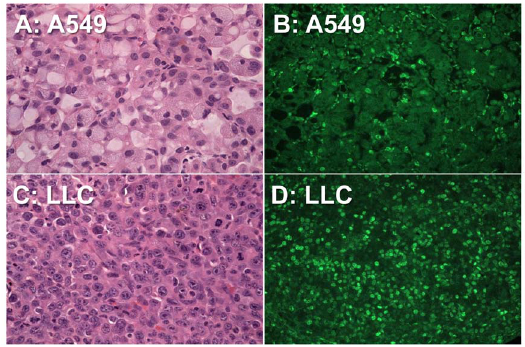
Figure 4. Micrographs of the A549 tumor and LCC tumor. Hematoxylin-eosin staining (original magnification 6 400) demonstrates that LCC ( C ) have higher cell density and larger cell nuclei compared to A549 ( A ). Ki-67 staining (original magnification 6 200) reveals larger fraction of positive cells seen in LCC ( D ) than in A549 ( B ). This indicates the presence of a larger number of cells in active phases of the cell cycle (G 1 , S, G 2 , and mitosis) and thus the aggressive nature of LCC.